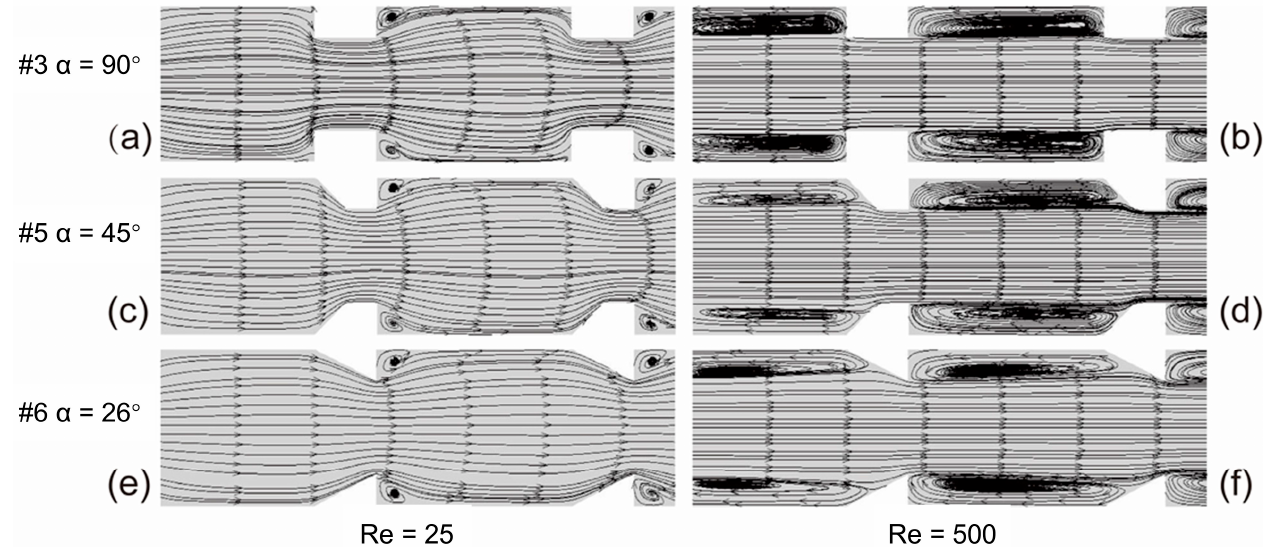
Figure 7. Streamlines in the transverse central section of the fluid with different fin incident angles: ( a ) α = 90°, Re = 25; ( b ) α = 90°, Re = 500; ( c ) α = 45°, Re = 25; ( d ) α = 45°, Re = 500; ( e ) α = 26°, Re = 25; ( f ) α = 26°, Re = 500.